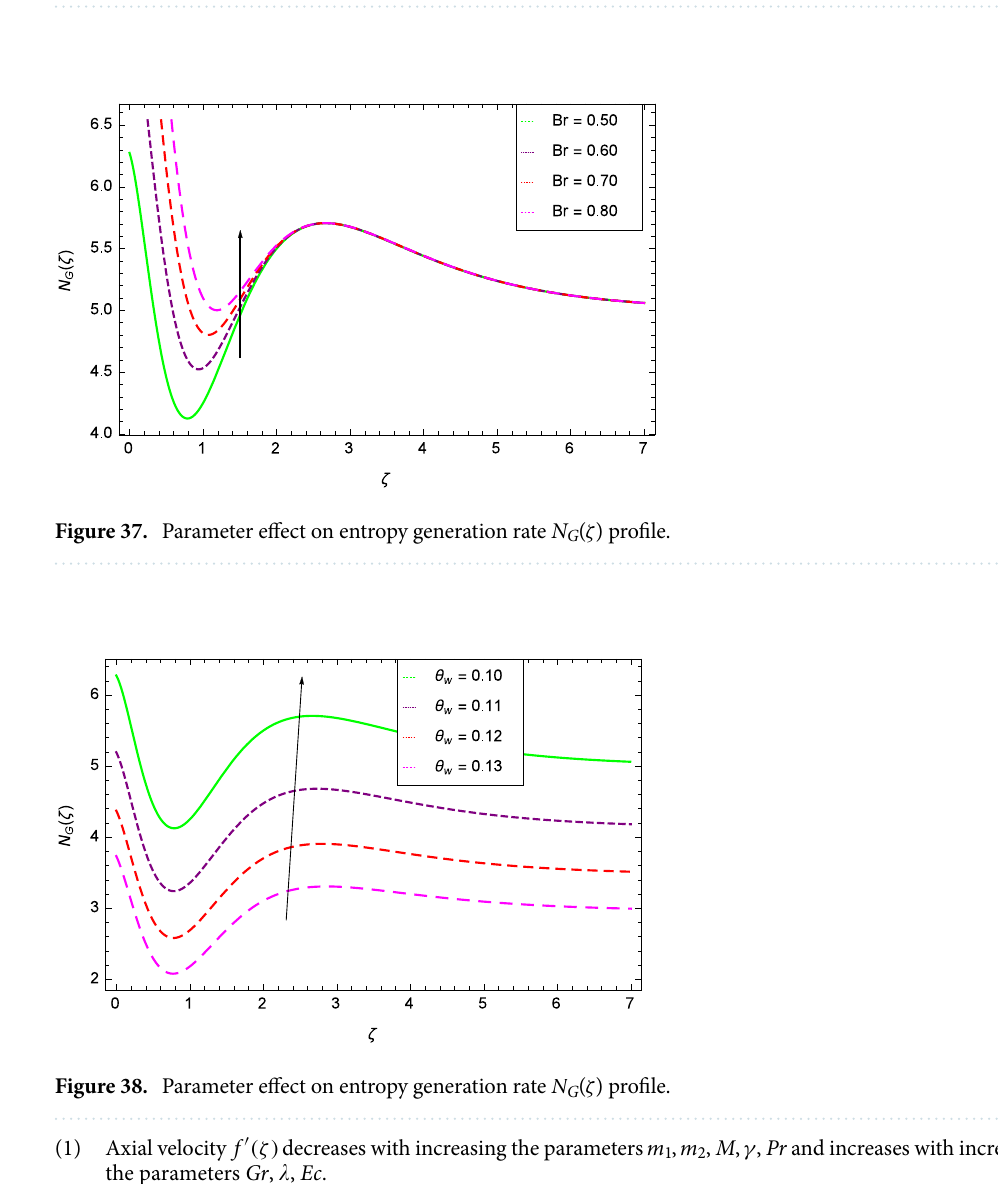
Figure 36. Parameter effect on entropy generation rate N G ( ζ ) profile.